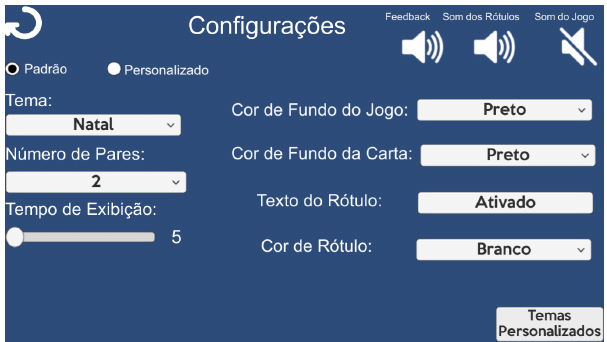
Figure 5. Cuca Fresca settings menu